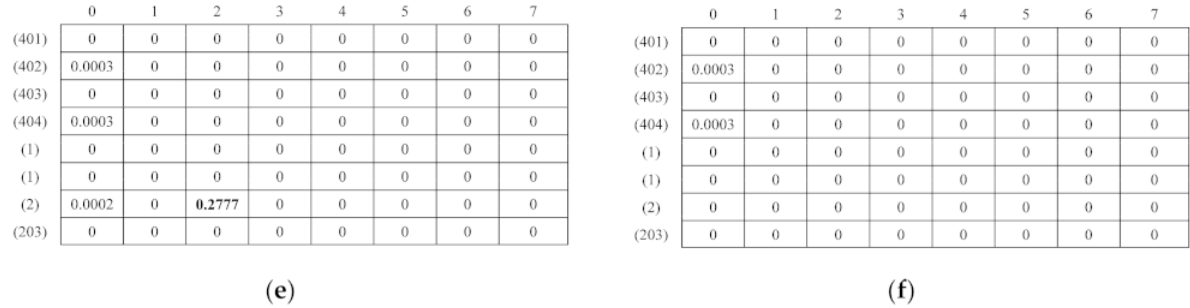
Scheme 1. Steps of extracting multiple single-target state estimate based on U . ( a – f ): the successive steps of extracting multiple single-target state